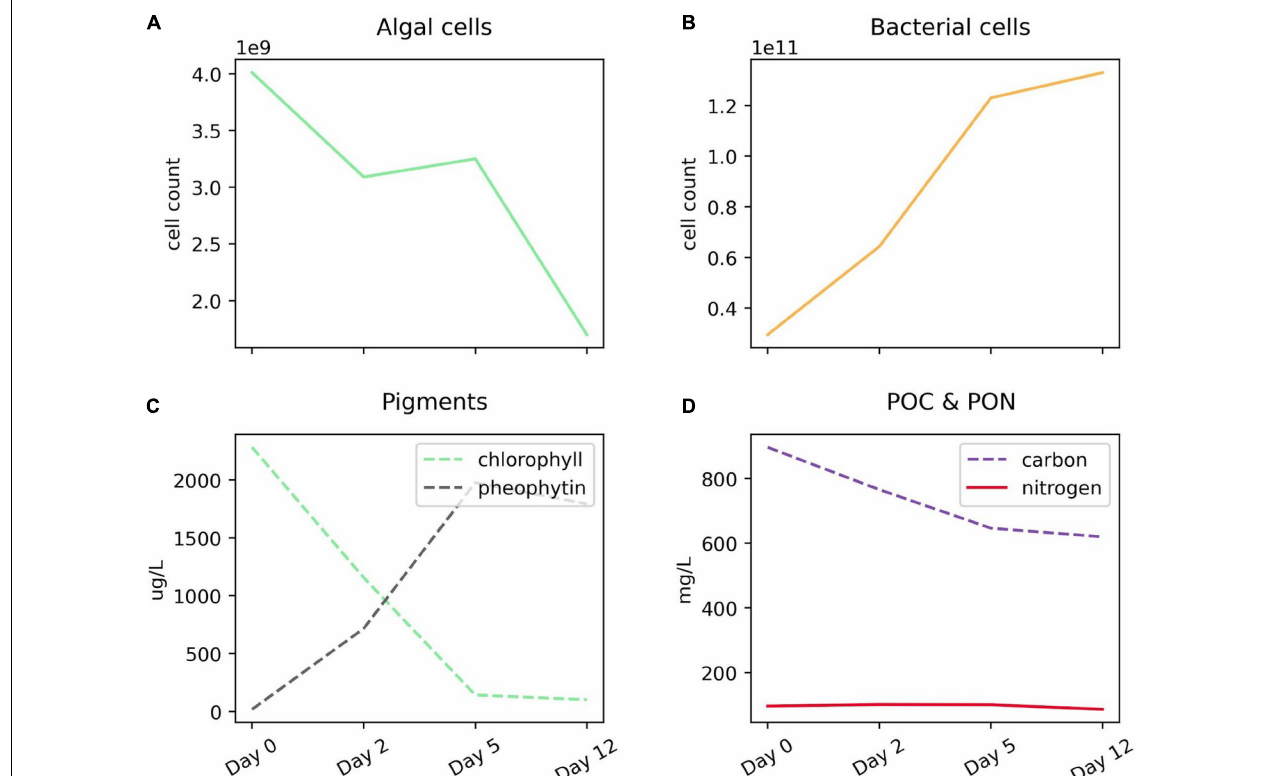
FIGURE 1 | Progression of Thalassiosira weissflogii degradation experiment. (A) Algal and (B) bacterial cell counts over the 12-day incubation period; (C) chlorophyll and its degradation product, pheophytin; and (D) particulate carbon and nitrogen (filtered on GF/F membranes). While algal cellular material is degrading between days 2 and 5, the silica-based cell walls remain and are identifiable via microscopy, leading to the static or slightly increasing diatom cell counts (A) . For more information about algal degradation see Adams et al.